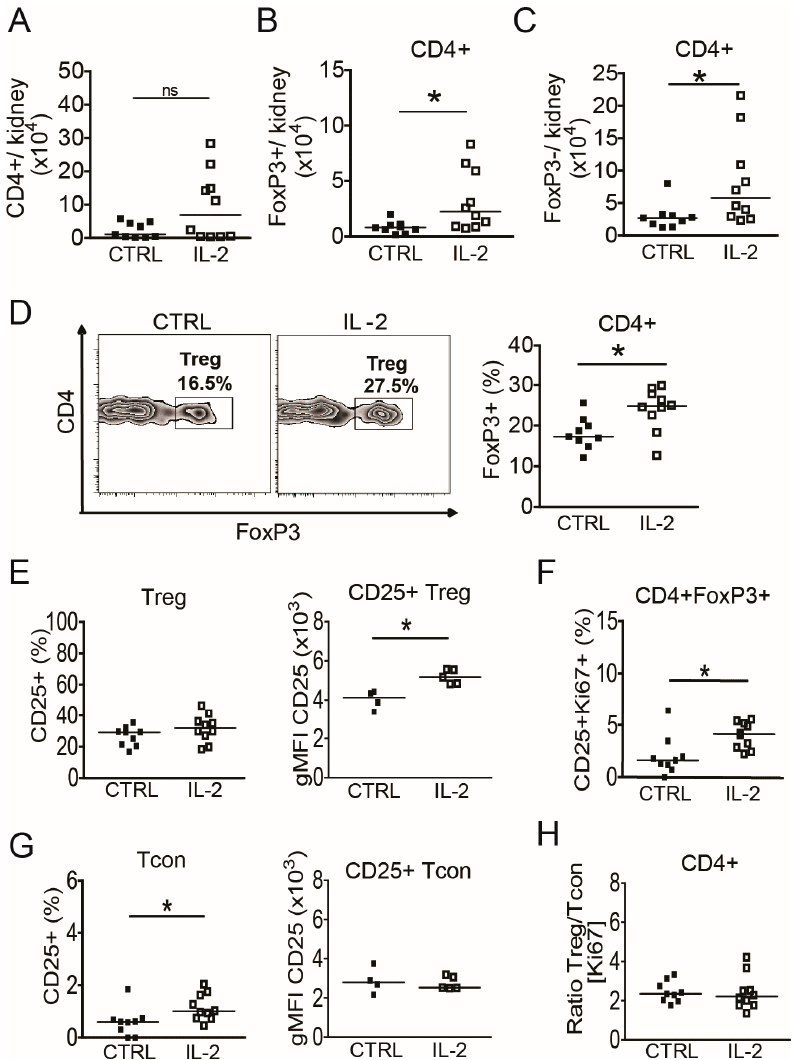
Figure 4. Short-term IL-2 treatment expands the intrarenal Treg population. Cells from kidneys of (NZB × NZW) F1 mice at the disease onset were analyzed by flow cytometry 24 h after a 5-day treatment course with daily injections of rIL-2 and compared with PBS-treated control mice. ( A – C ) Total numbers of intrarenal CD4 + T cells ( A ), of intrarenal CD4 + FoxP3 + Treg ( B ) and of intrarenal CD4 + FoxP3- Tcon ( C ) from IL-2 treated mice (IL-2) compared to control mice (CTRL) are shown. ( D ) Representative contour plots and scatter plot show the frequencies of FoxP3 + cells among CD4 + T cells in IL-2 treated mice compared to controls. ( E ) The frequency of CD25 + cells among CD4 + FoxP3 + Treg and the geometric mean fluorescence intensity (gMFI) of CD25 in CD4 + FoxP3 + CD25 + Treg are shown. ( F ) The percentage of intrarenal CD25 + Ki67 + cells among CD4 + FoxP3 + Treg is shown. ( G ) The frequency of CD25 + cells among CD4 + FoxP3 − Tcon and the gMFI of CD25 in CD4 + FoxP3-CD25 + Tcon are shown. ( H ) The calculated ratio between percentages of Ki67 + Treg and of Ki67 + Tcon is shown. Filled squares indicate PBS treated control mice (CTRL, n = 9) and open squares represent IL-2 treated mice (IL-2, n = 10). Horizontal lines represent the median. Mann-Whitney U test was used for statistical analyses (* p <